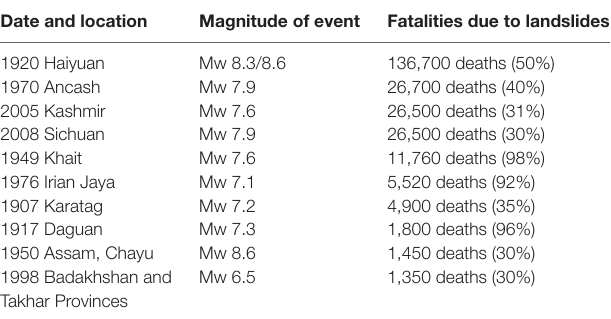
Table 2 | The effect of larger landslide events since 1900. Date and location